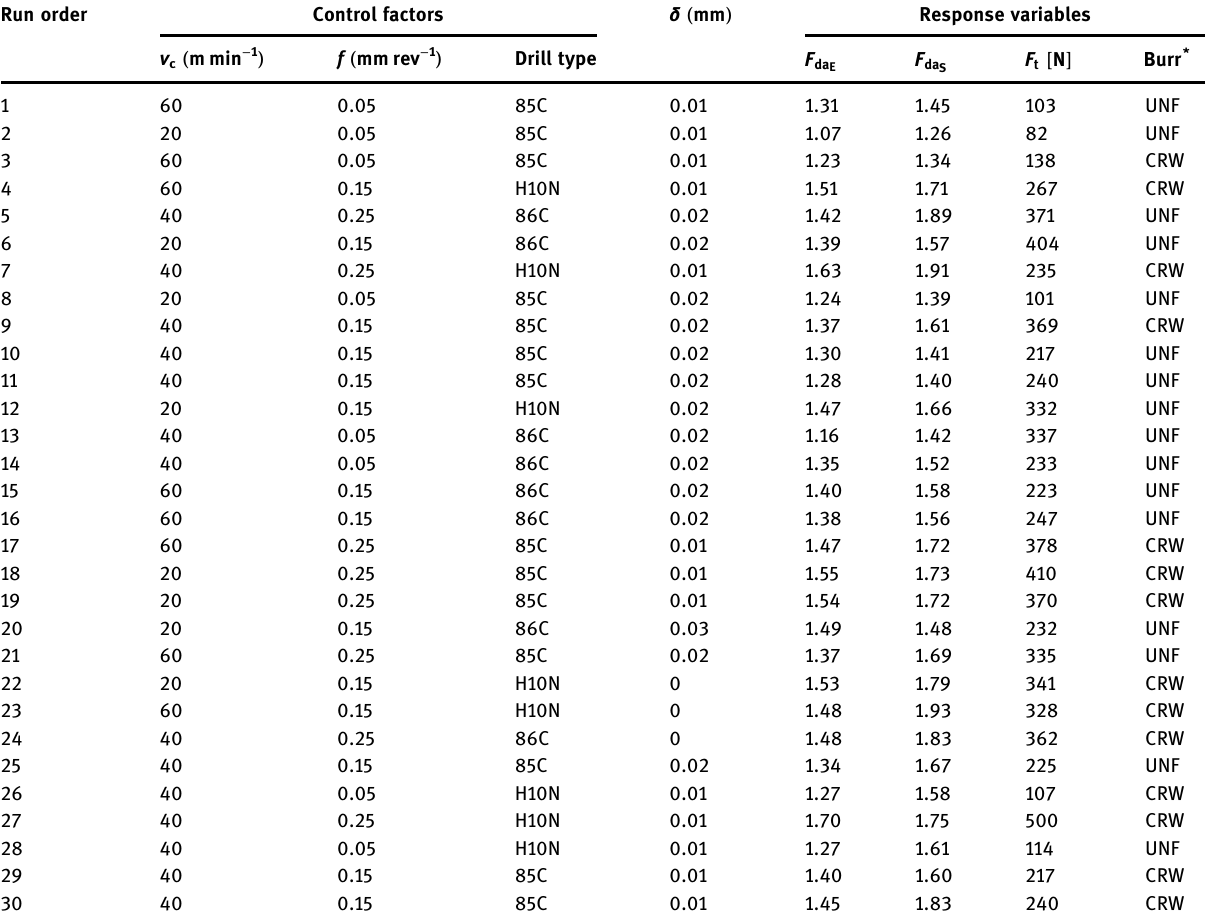
Table 4: Response variables and control factors Run